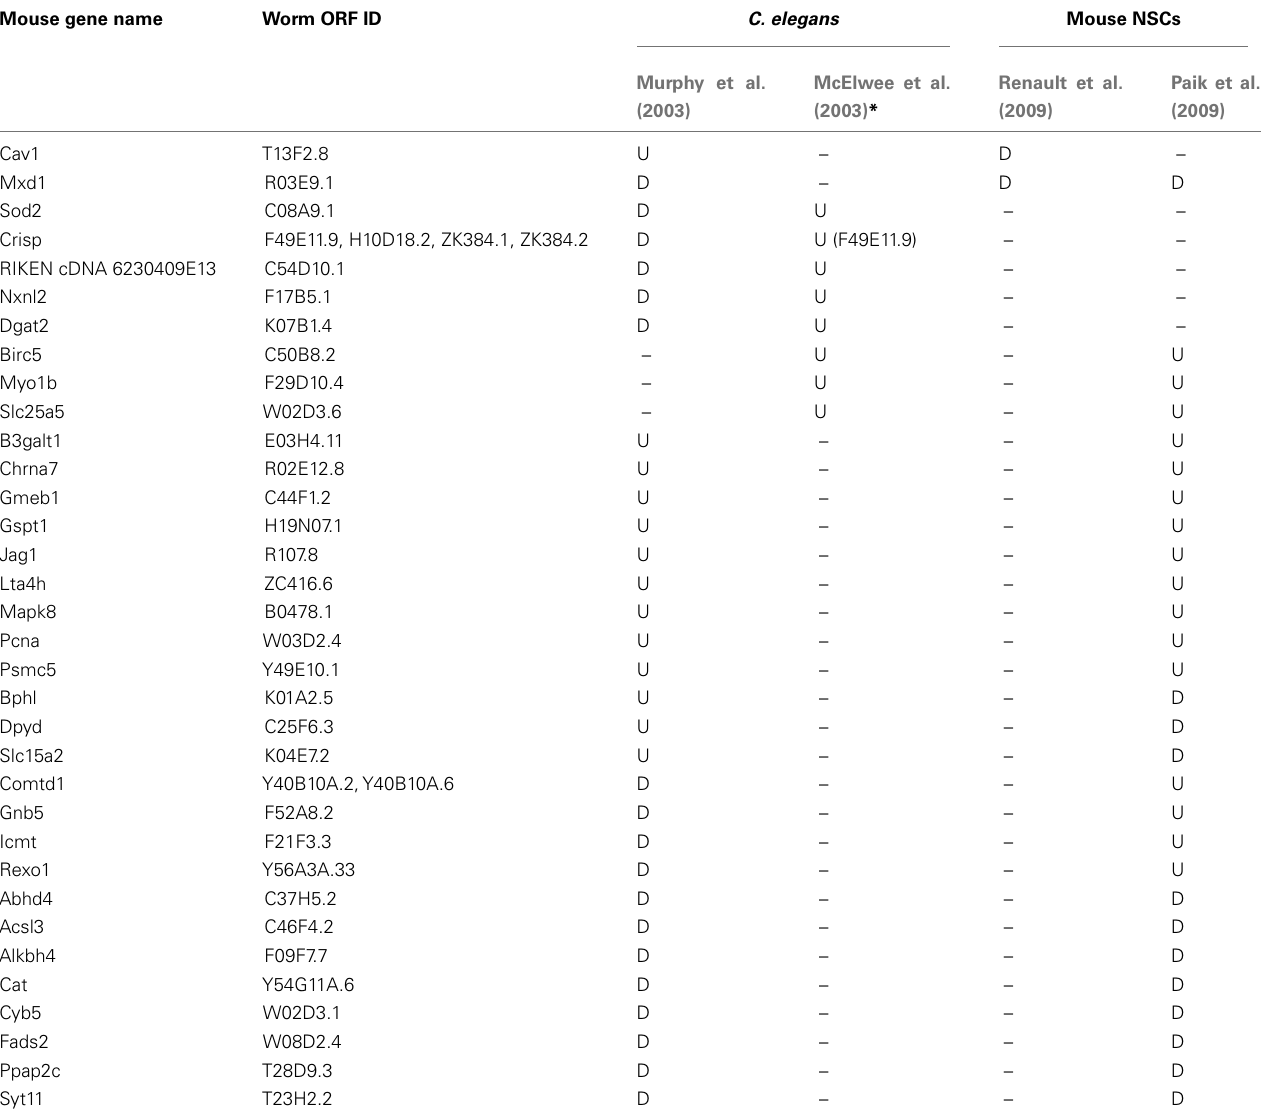
Table 1 | Putative FOXO targets emphasized by microarray analysis in either C. elegans or mouse NSCs, or